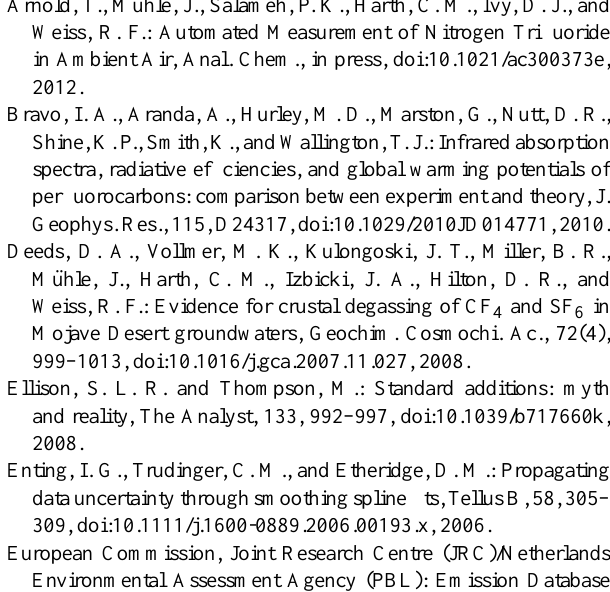
Fig. 5. Same as Fig. 1, but for C 8 F 18